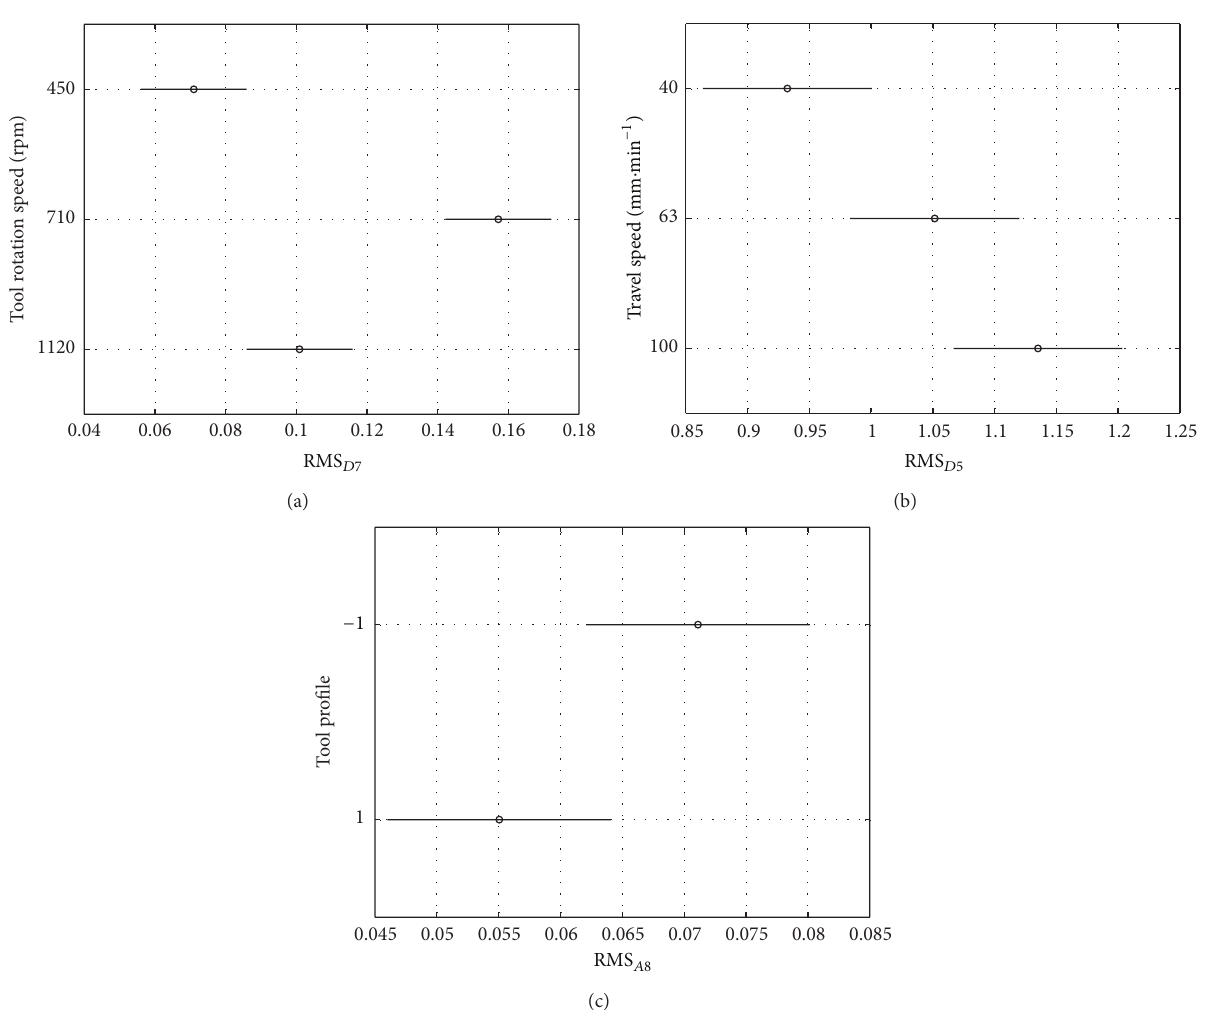
between the process parameters and mechanical property of the FSW joint and values calculated using the ANN. The obtained correlation factor is also shown as a result of the regression